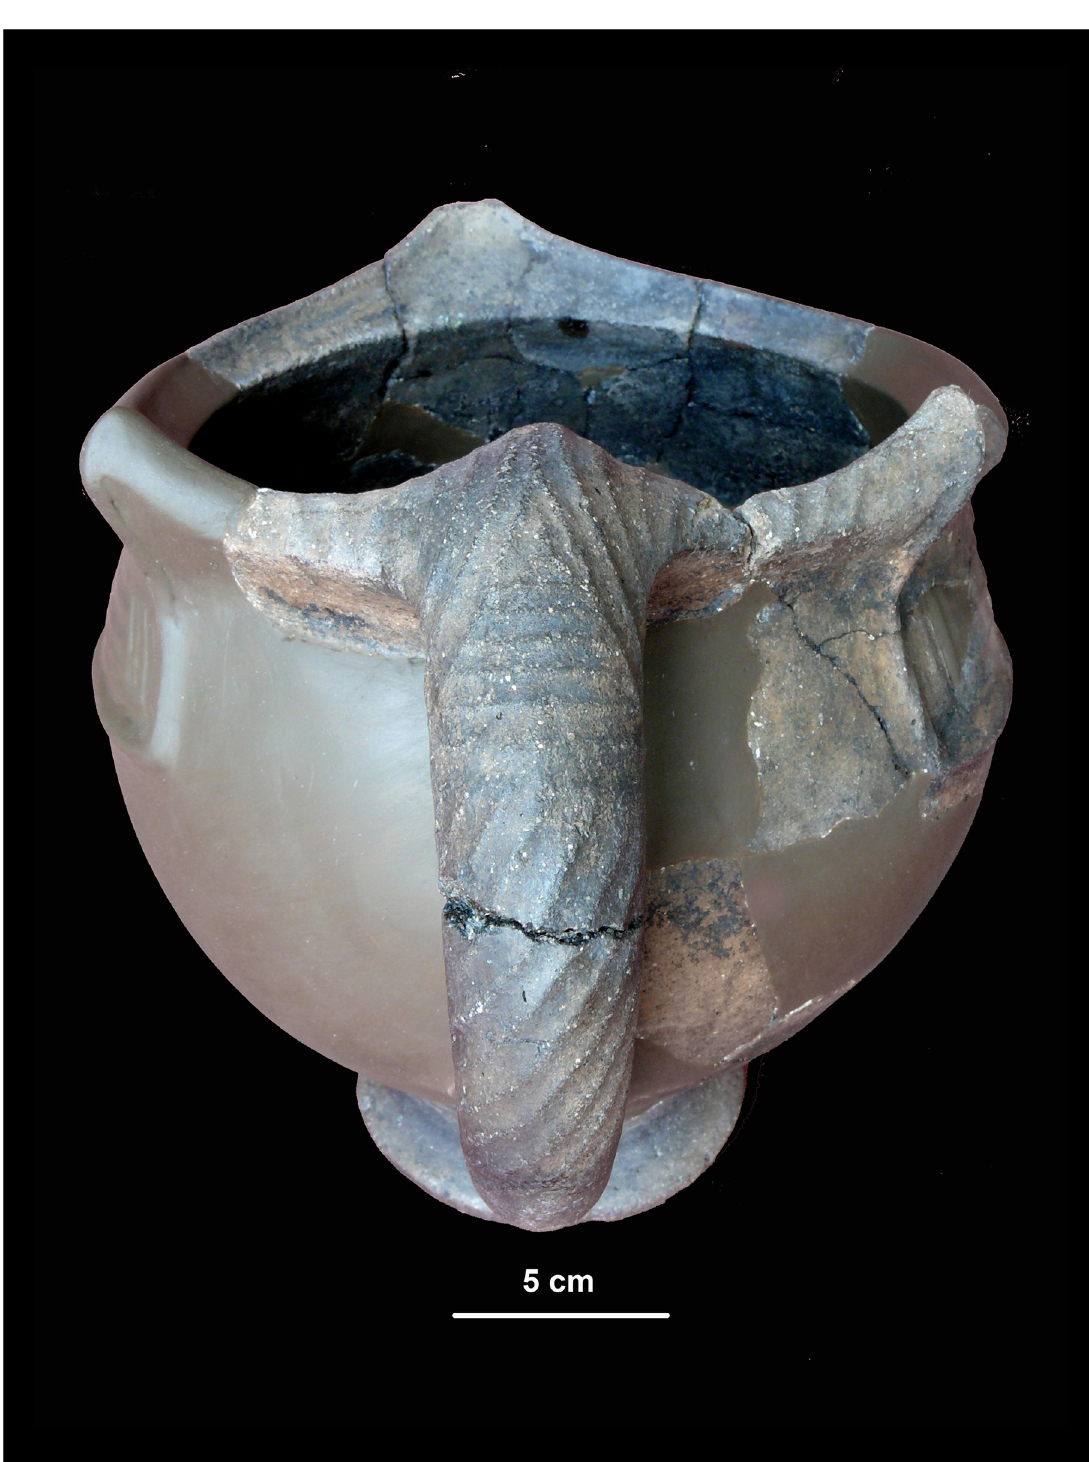
Fig 9. Luco A type vessel (photo by Gu ¨ nther Niederwanger, courtesy of Ufficio Beni Archeologici di Bolzano).